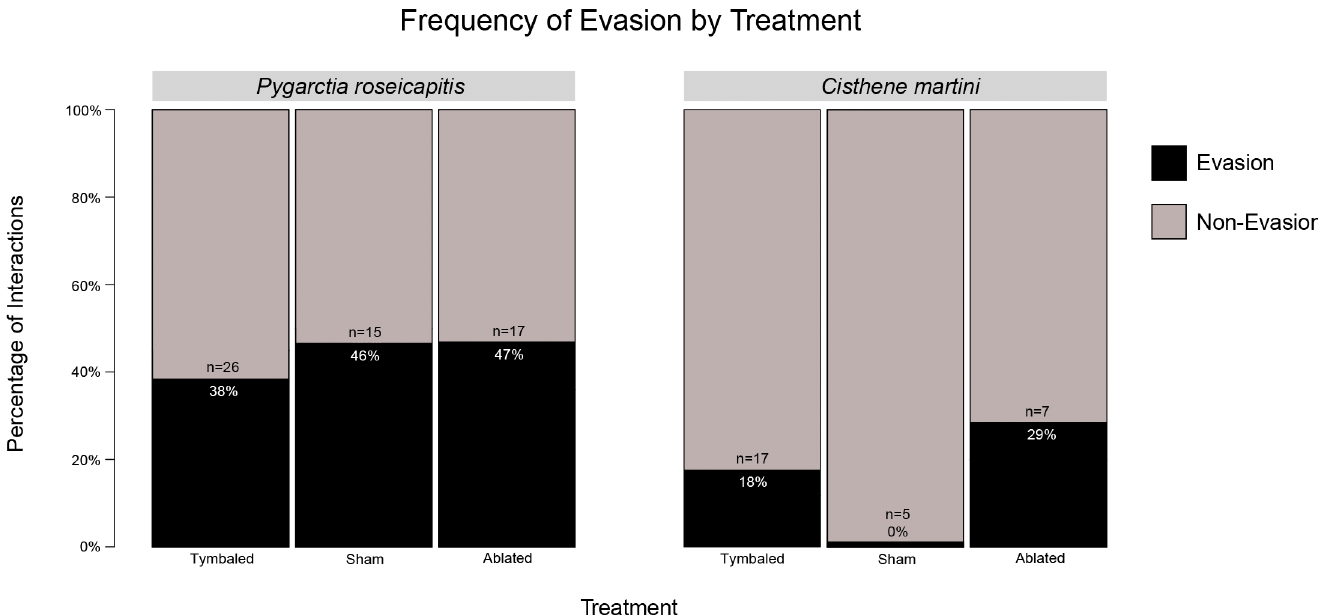
Fig 7. Percentage of interactions hand-scored as “ Evasion ” by treatment for P . roseicapitis and C . martini . Numbers within each bar indicate the number of interactions observed for that treatment group and percentages indicate the percent of those observations that were scored as “ Evasion ” .